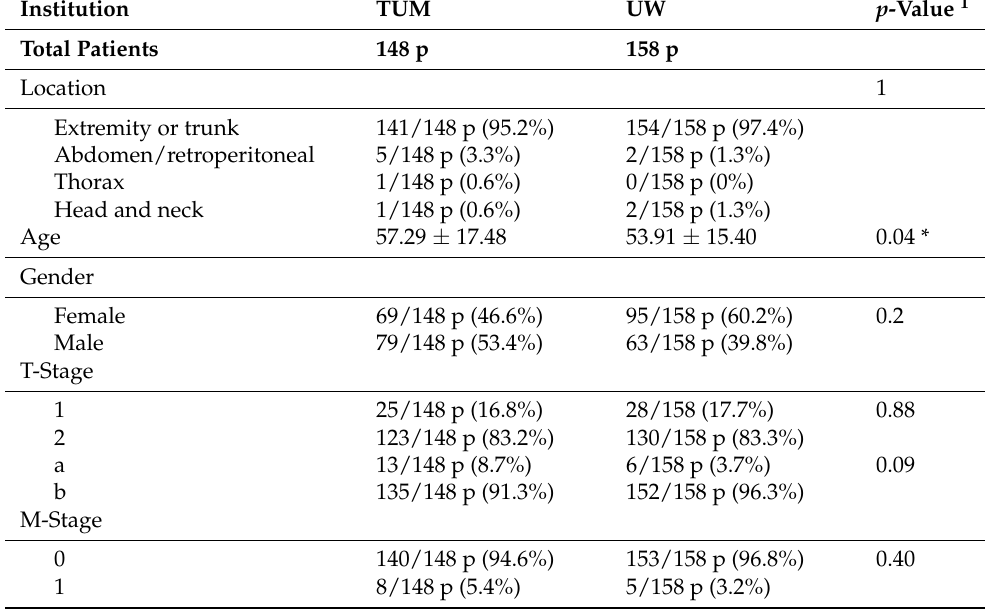
Table 1. Patient demographics and